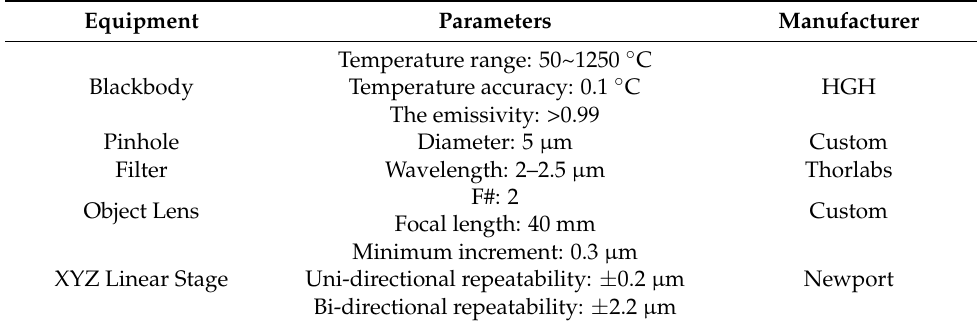
Figure 1. Experimental setup of the intra-pixel sensitivity for infrared focal plane array. Table 1. Specifications of experimental setup.